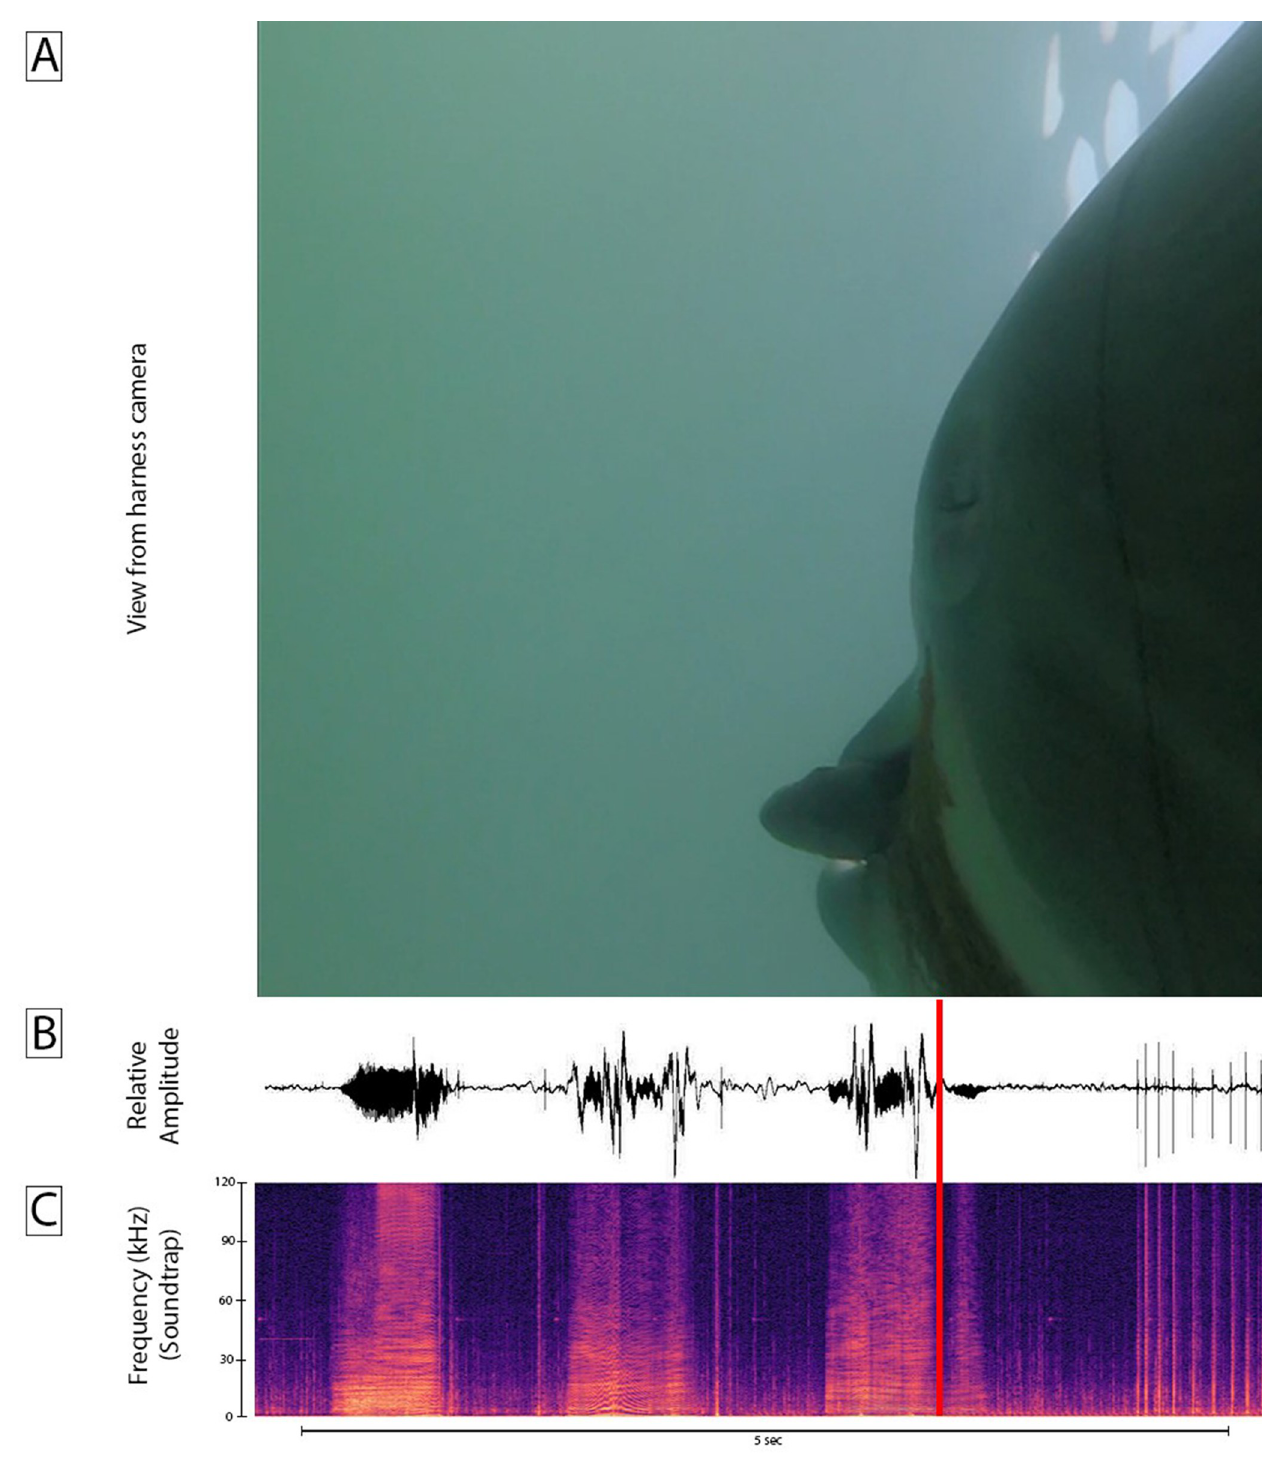
Fig 3. Dolphin K captures live fish in San Diego Bay. A. View of dolphin K while capturing fish. B. Relative amplitude of sound recorded from dolphin K during the capture observed in A . C . Audible frequencies of sound recorded from dolphin K during the capture observed in A . The red bar shows the point of capture. Echolocation clicks appear at the end of this recordings as the dolphin searches for another fish.